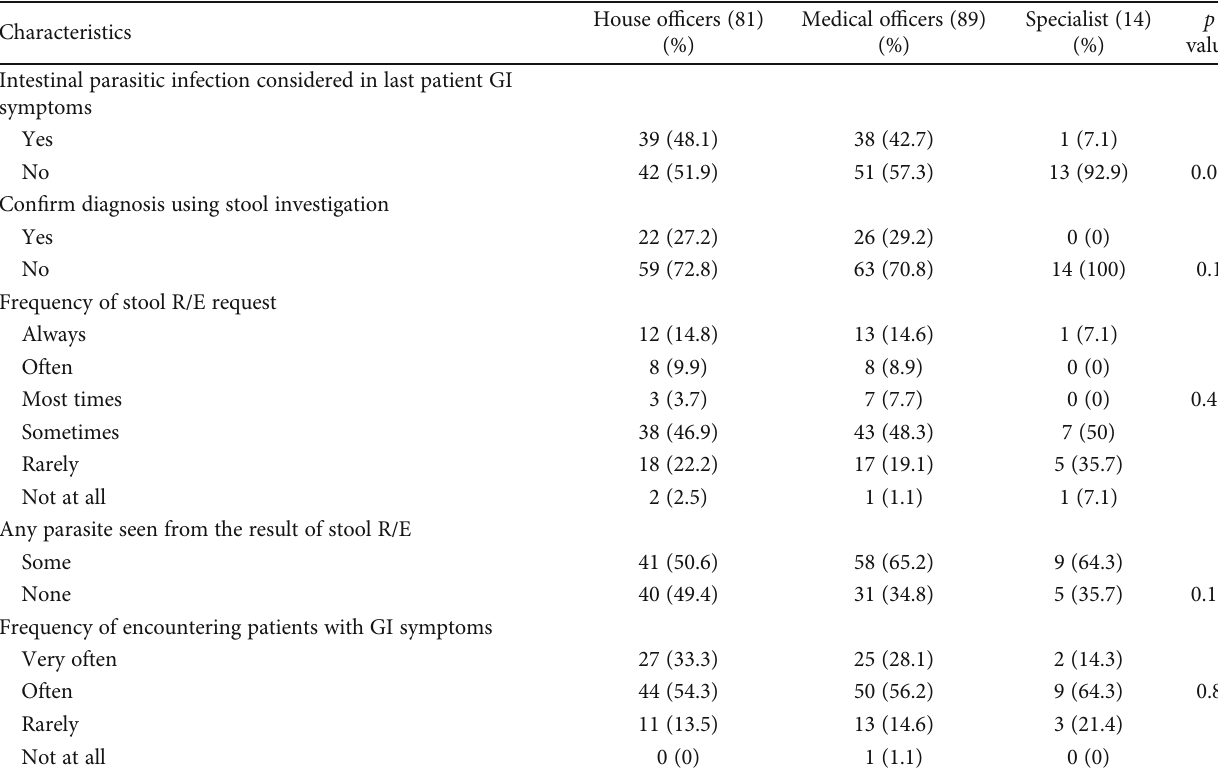
Table 3: Characteristics of physicians strati fi ed by cadre.